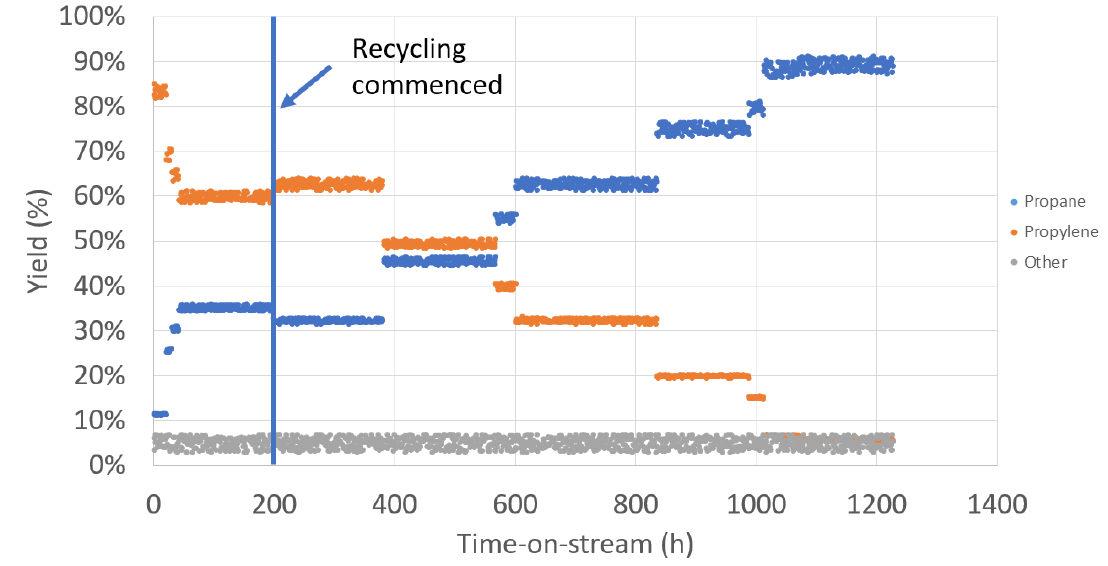
Figure 7. Results from operating the entire pilot plant from glycerol to propane, recycle initiated at about 200 h. Modified and reproduced with permission [37].